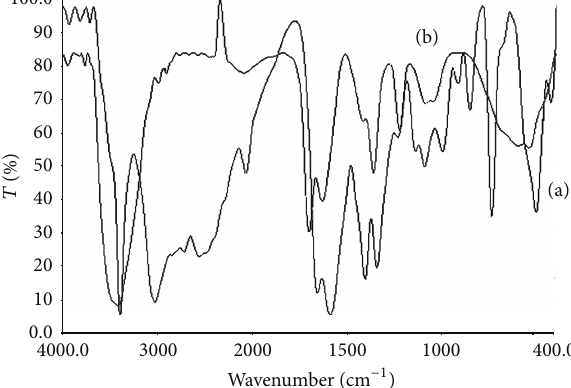
Figure 3: FTIR spectra. (a) Pure L-Arginine. (b) Film formed on the metal surface after immersion in the sea water for 1 day containing 250 ppm of L-Arg and 25 ppm of Zn 2+ .